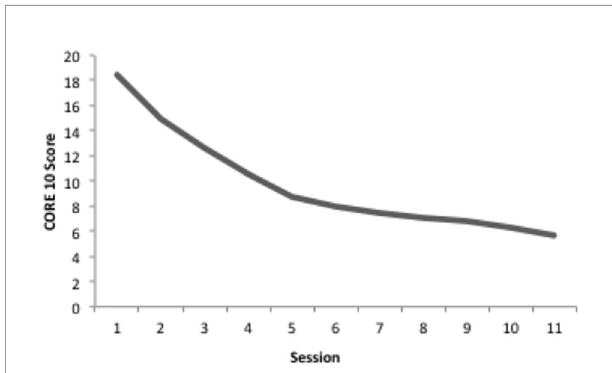
FIGURE 3 | The trajectory of CORE 10 scores for a simulation based on the principle of reorganization. Original fi